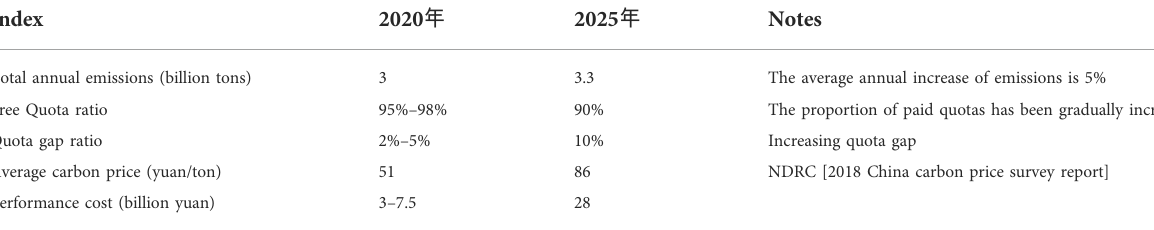
TABLE 1 The constraints of the national